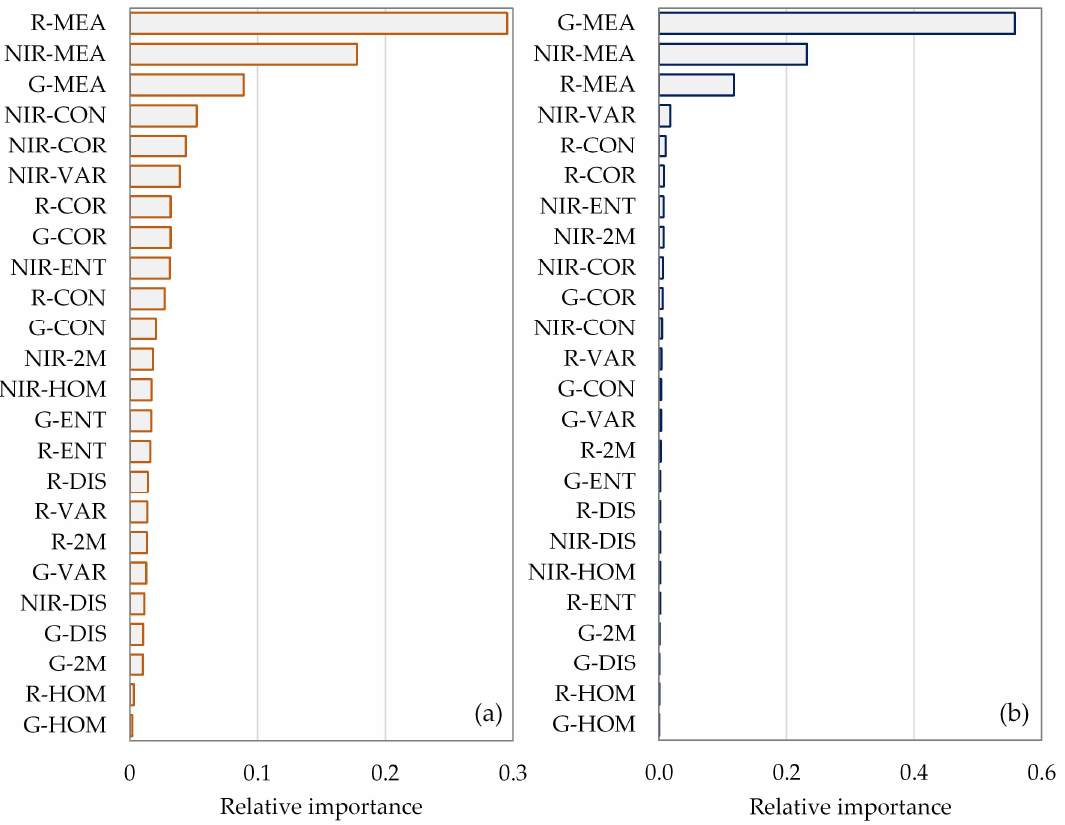
Figure 6. Relative importance of the predictor variables as measured by the feature importance metric in the best extreme gradient boosting (XGBoost) models predicting aboveground biomass (AGB) ( a ) and canopy height (CH) ( b ).